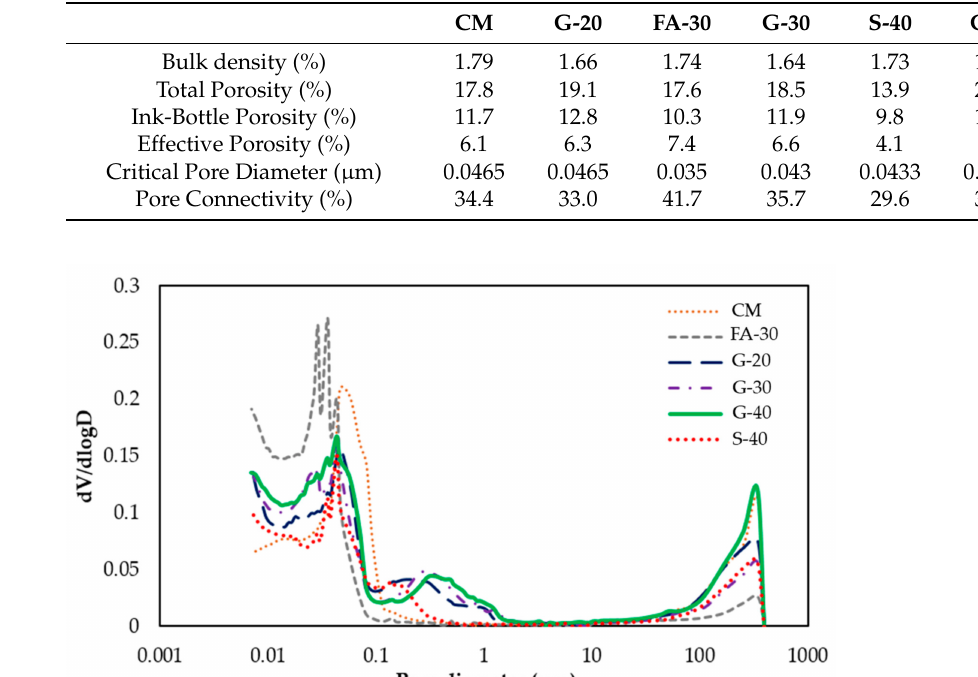
Figure 15. Critical pore entry